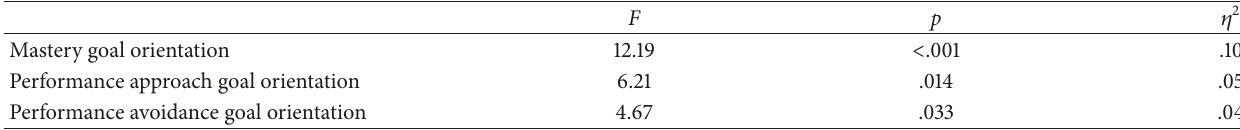
Table 3: Univariate ANOVAs of the main effect of time of measurement on achievement goal orientations before and after the learning phase (𝑁 = 111) . F p 𝜂 2